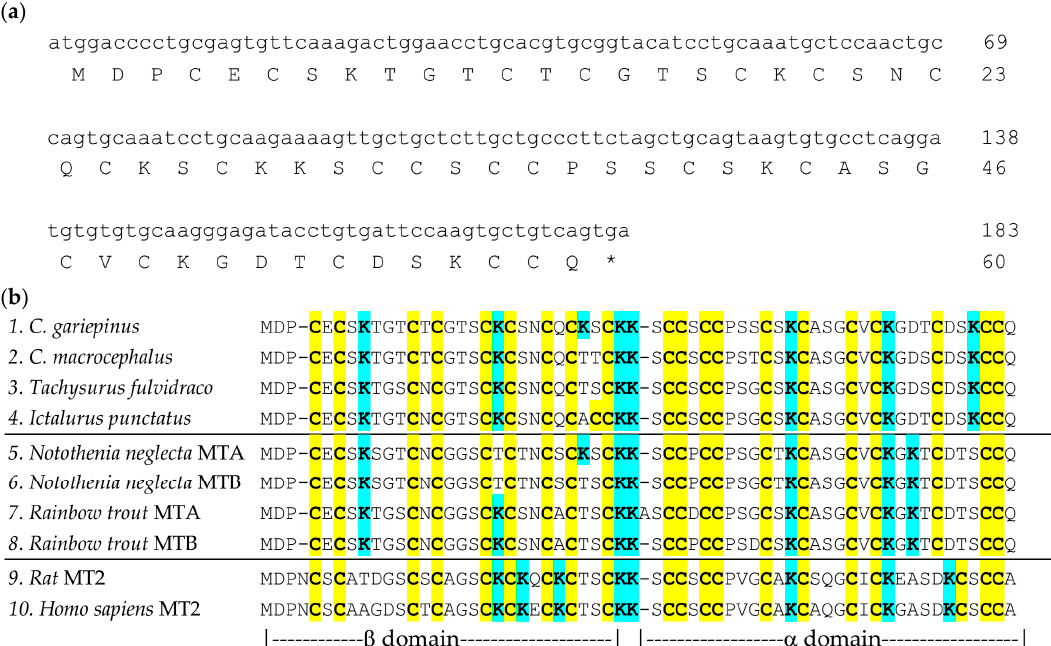
Figure 2. ( a ) Cloned cDNA sequence of cgMT and predicted amino acid sequence of CgMT. At the end of each line, the position of the last nucleotide/amino acid is marked; ( b ) Sequence alignment of CgMT (row 1) with MTs from other catfish (rows 2–4), other fish (rows 5–8), and two mammalian MTs (rows 9 and 10). Cysteines and lysines are highlighted in yellow and cyan, respectively.